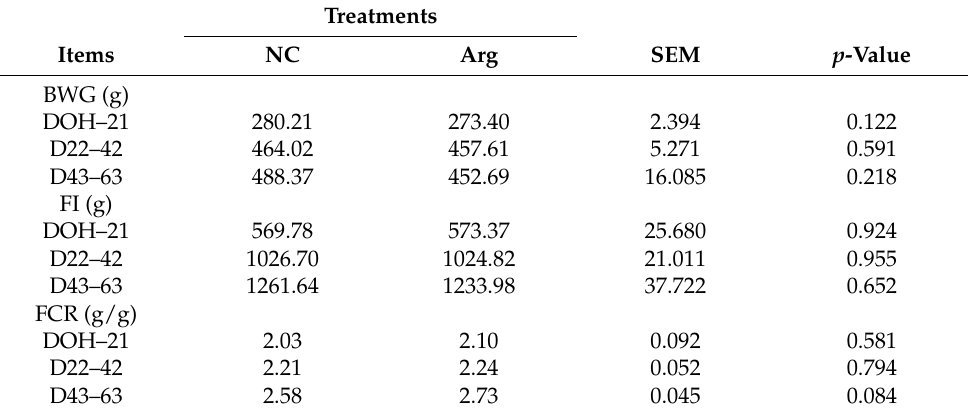
Table 3. Effects of in ovo feeding of L-arginine on growth performance of slow-growing chickens.